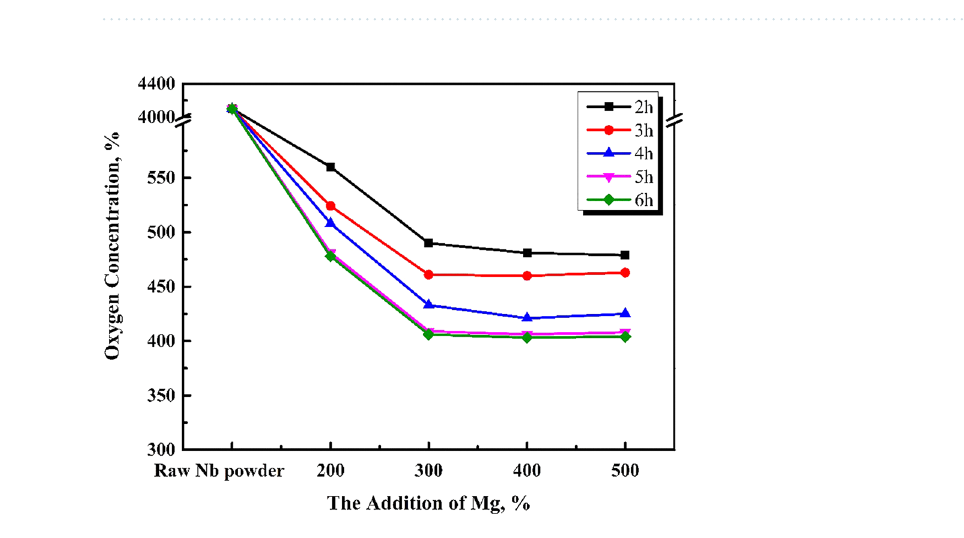
Figure 4. Oxygen content of pickling niobium powder at 953 K for 8 h with various amounts of magnesium additions.